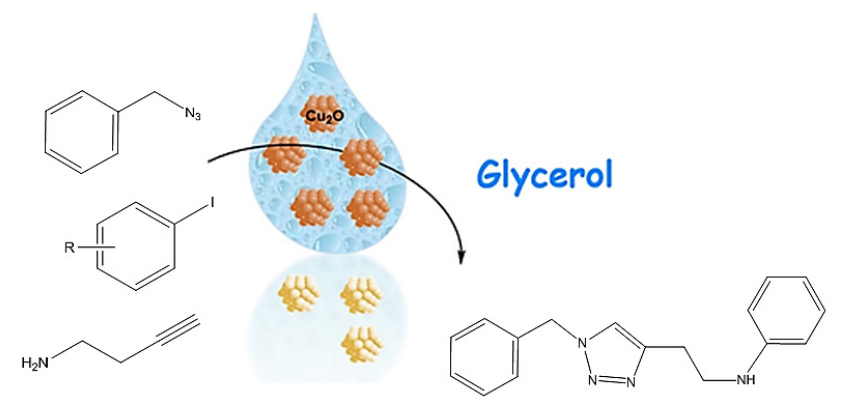
Figure 3. Example of the use of glycerol with nano oxides. Reproduced with permission from [9], published by Elsevier B.V., 2017.